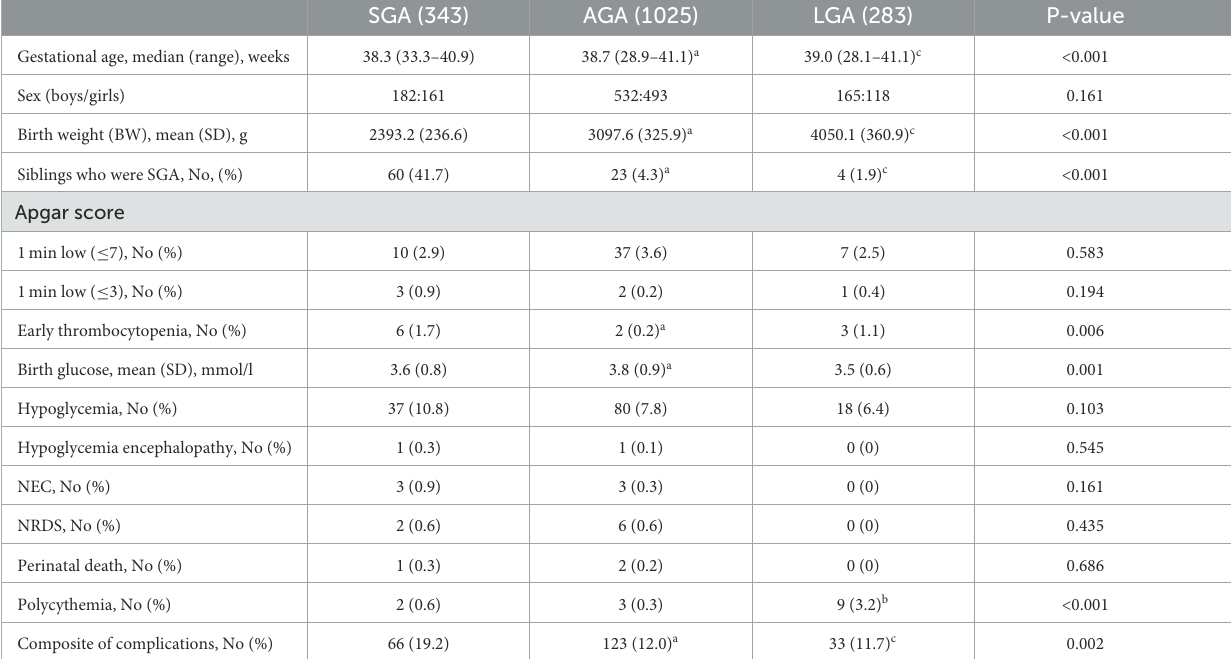
TABLE 2 Clinical characteristics of the infants ( N = 1,651).